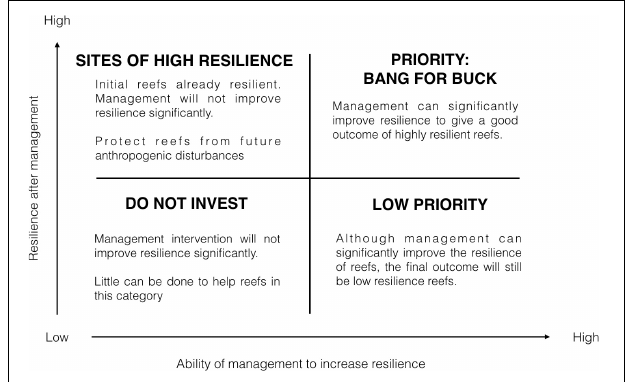
FIGURE 3 | Decision making framework for investment strategy for locations with varying resilience levels and potential management impact, modified from Mumby and Anthony